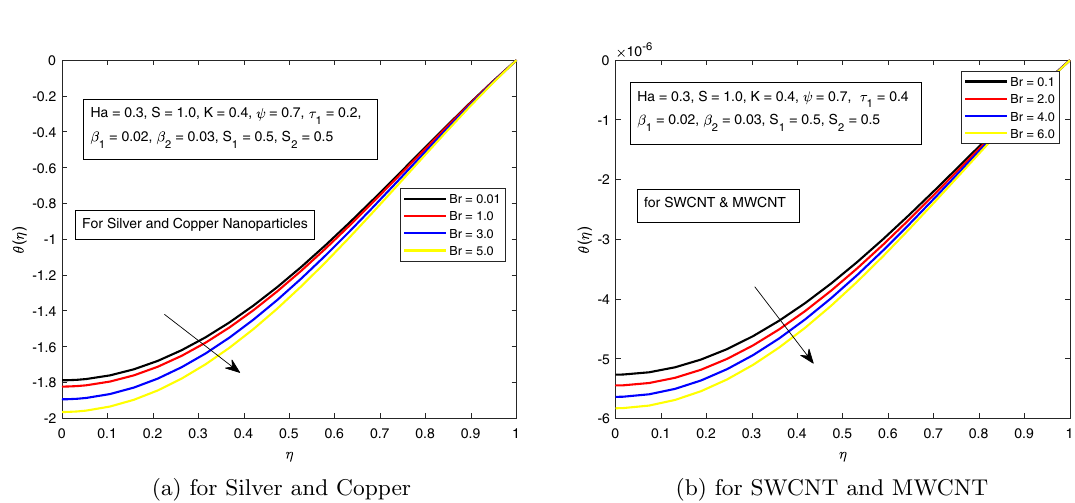
Figure 7. Influence of τ 1 on temperature distribution θ( r ) for the hybrid nanofluid combination of ( a ). Ag and Cu , ( b ) SWCNT and MWCNT .